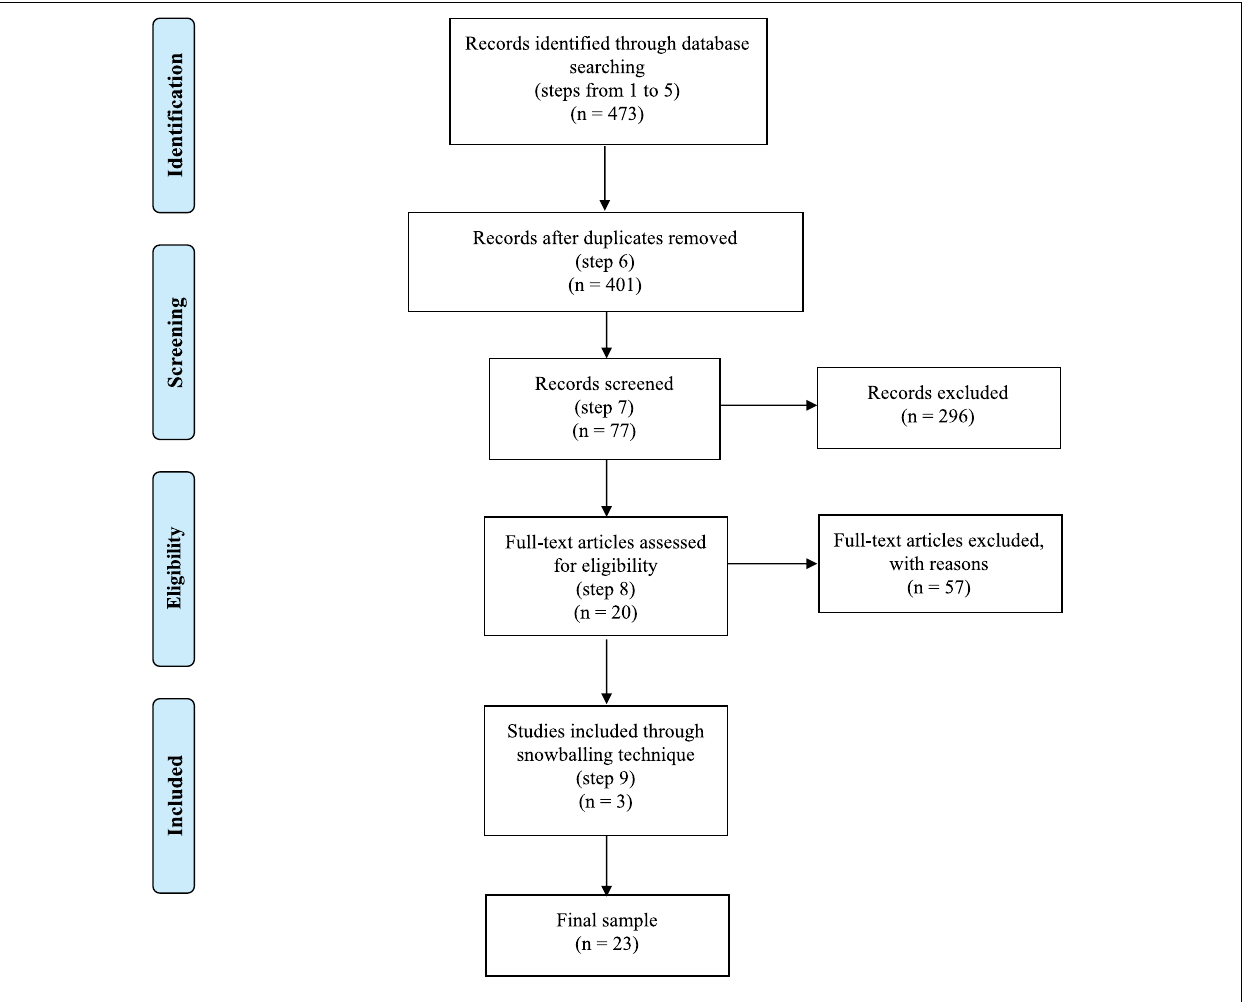
FIGURE 1 | PRISMA representation of papers’ collection